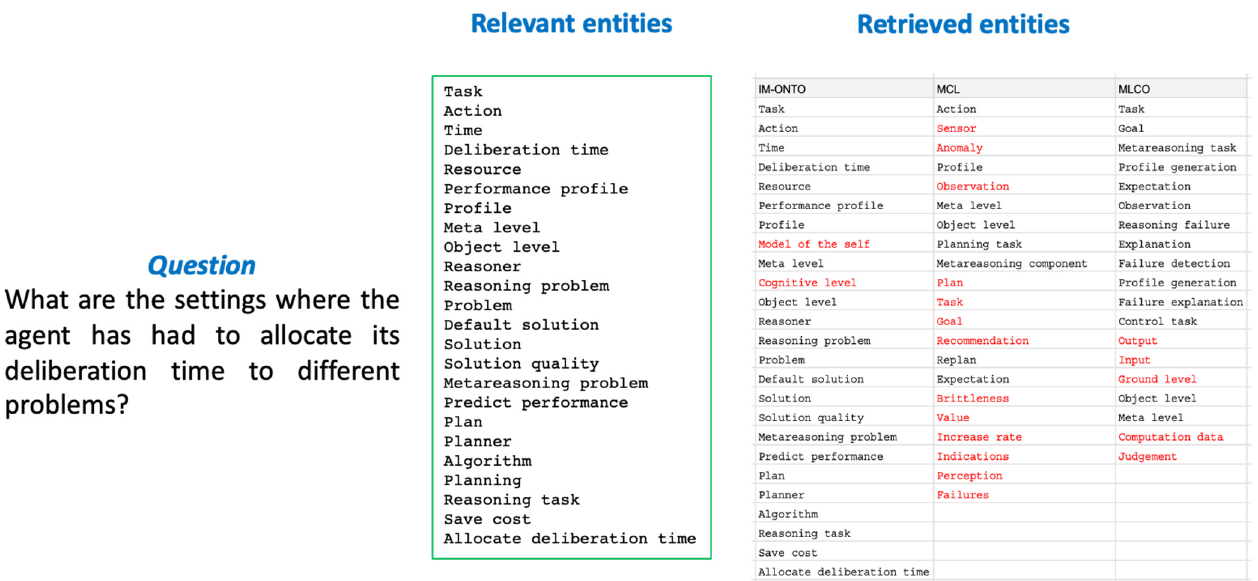
Figure 18. Sample of questions. Manually annotated questions for relevant and retrieved entities. In the response to the question formulated, the terms highlighted in red were not recovered by the corresponding ontologies. Table 5. Precision and recall rates for comparing ontologies.